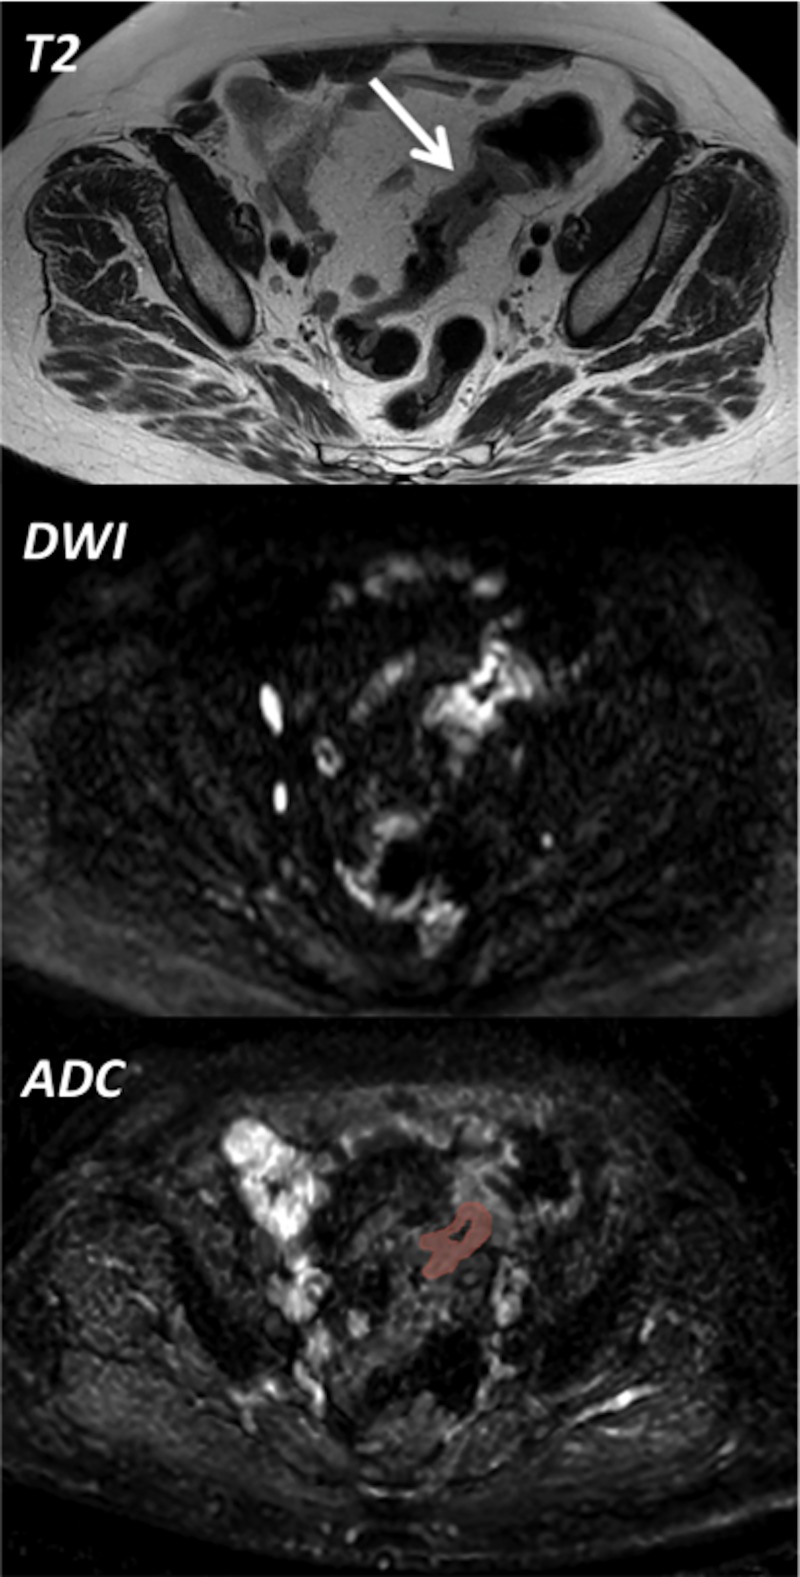
Example of image processing.The T2 weighted MRI sequence (top picture) is showing the tumor in the sigmoid colon (arrow). The middle picture is the corresponding b1000 weighted DWI (Diffusion Weighted Imaging) sequence showing a high signal intensity within the tumor (consistent with malignancy). Bottom picture shows an example of tumor delineation on the corresponding ADC (Apparent Diffusion Coefficient) as performed to obtain the mean ADC-value of the whole tumor. An abdominal radiologist with 13 years experience in reading abdominal MRI and a radiology resident delineated each tumor in consensus directly on the ADC map whilst referring to the T2 weighted images (top) and the DWI sequence (middle) for anatomical reference.